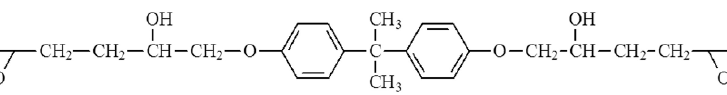
Figure 5. Chemical structure of E44. Table 2. Relative contents of functional groups on the CF surface.